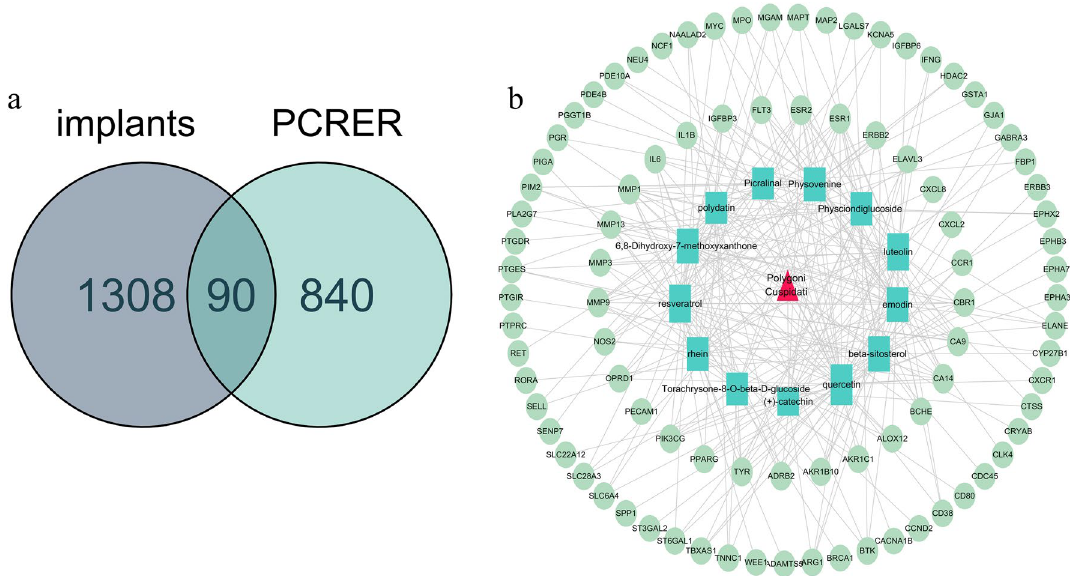
Figure 3. ( a ) 90 crossed targets common between the predicted PCRER targets and the Peri-implants- associated targets. ( b ) Network of targets predicted using the PCRER-derived compounds. Green nodes represent the active compounds, whereas the Lake blue nodes represent the predicted targets. These edges represent the interaction between the compounds and the targets, and the node size is proportional to the degree of interaction (Cytoscape 3.7.2 https:// cytos cape.